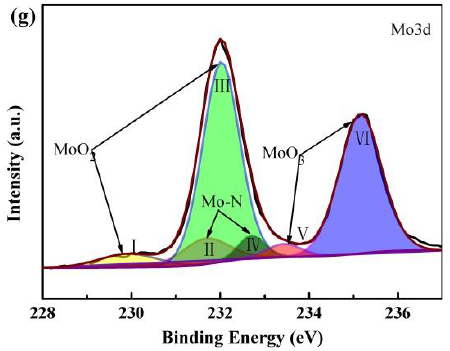
Figure 3. XPS spectra of MON-QD/NG-600 sample: ( a ) survey; ( b ) O1s; ( c ) N1s; ( d ) C1s; ( e ) Mo3d spectrum of MON-QD/NG-500; ( f ) Mo3d spectrum of MON-QD/NG-600; ( g ) Mo3d spectrum of MON-QD/NG-700.